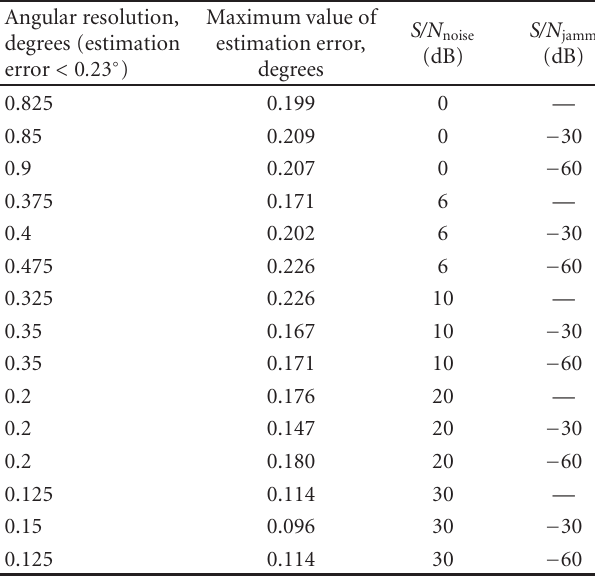
Table 1: The angular resolution and mean-square error of angular coordinates evaluated by means of the TLS ESPRIT